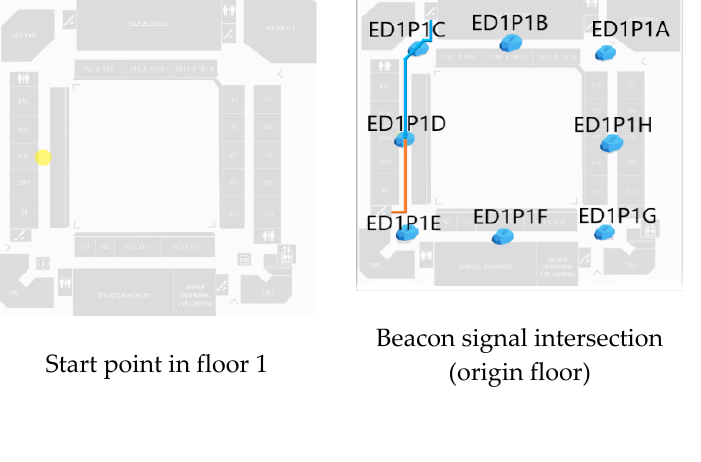
Figure 16. Test 2—Origin and destination ( Left ), paths using the stairs with beacons intersection signal ( Center ) and App screens ( Right ).